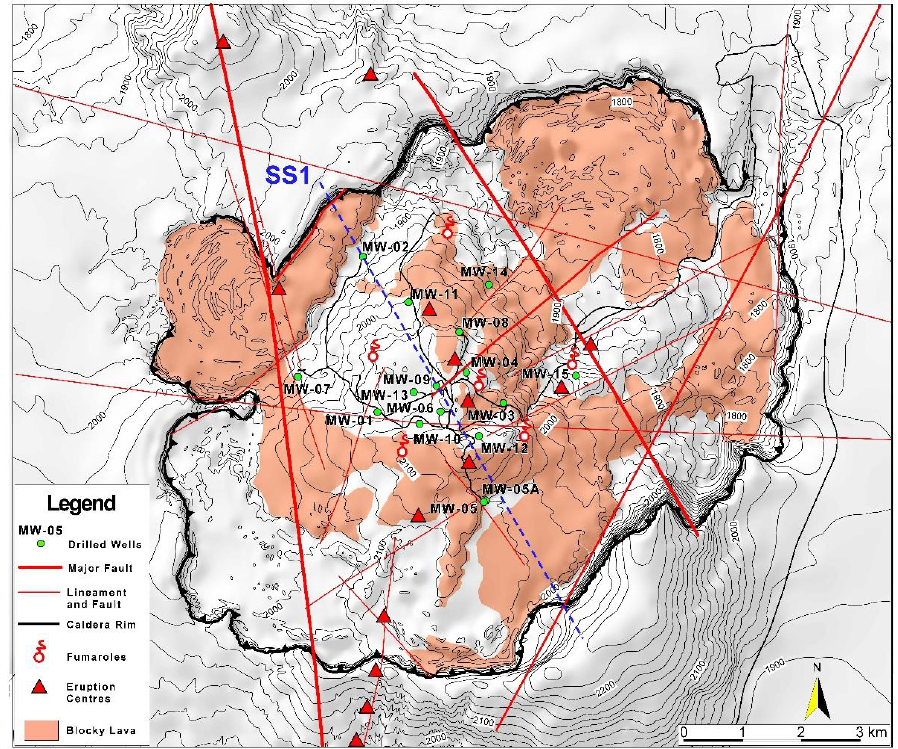
Figure 4. Geological – structural sketch of the Menengai caldera. The trace of the section SS1 is